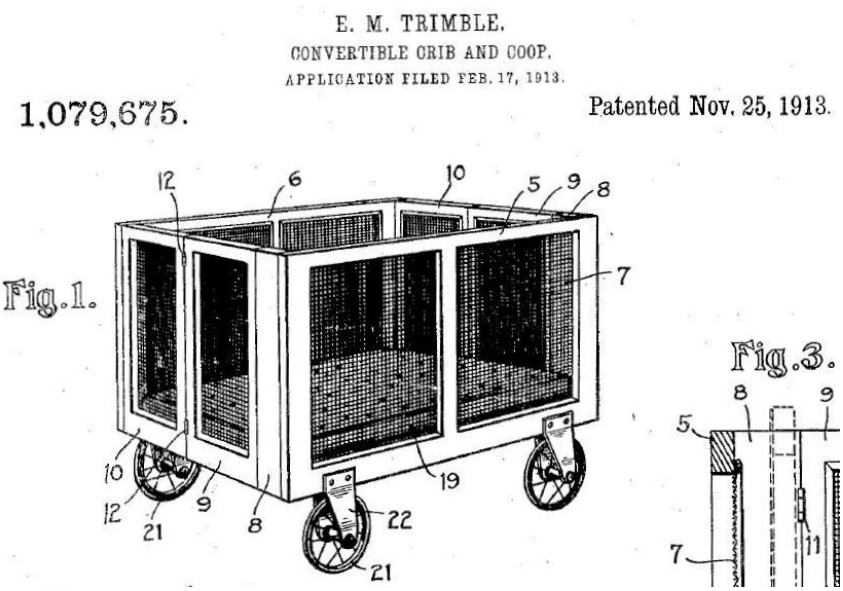
Figure 25. “Kiddie Koop,” a Screened Playpen on Wheels, Patented in 1913.